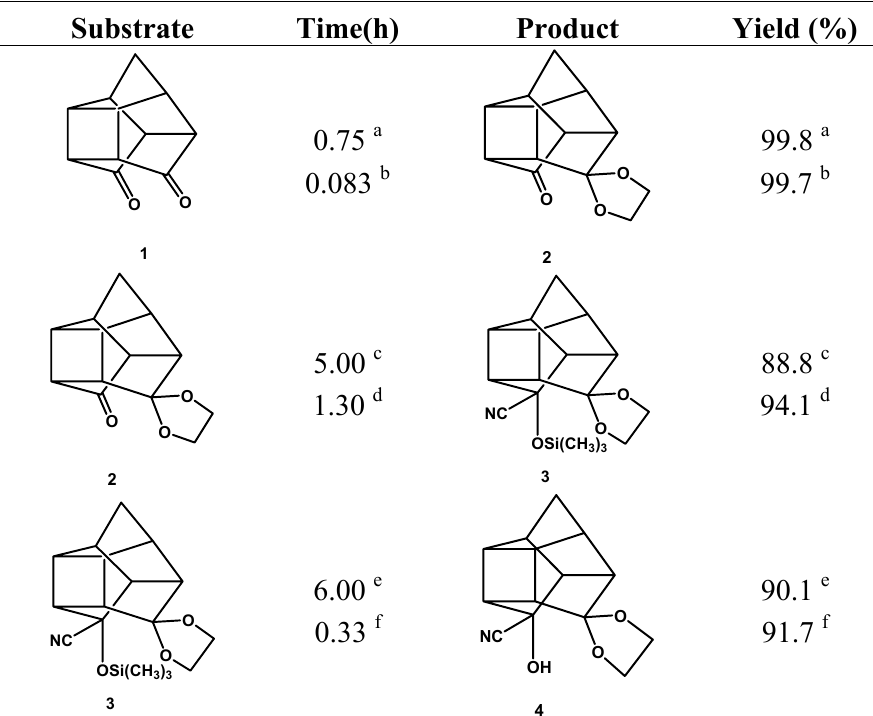
Table 2. Catalytic activity